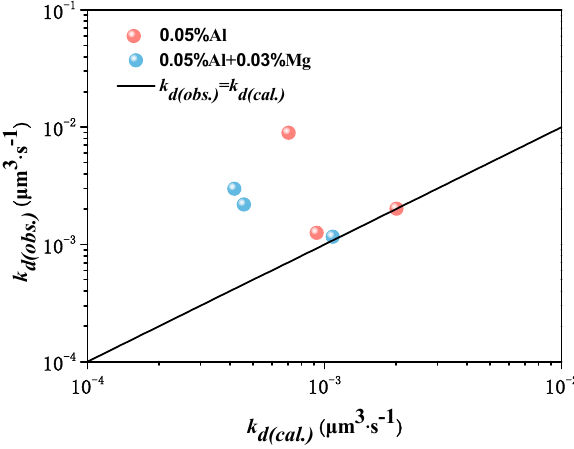
Figure 6. Comparison of k d(cal.) from Ostwald growth and k d(obs.) from inclusion size.